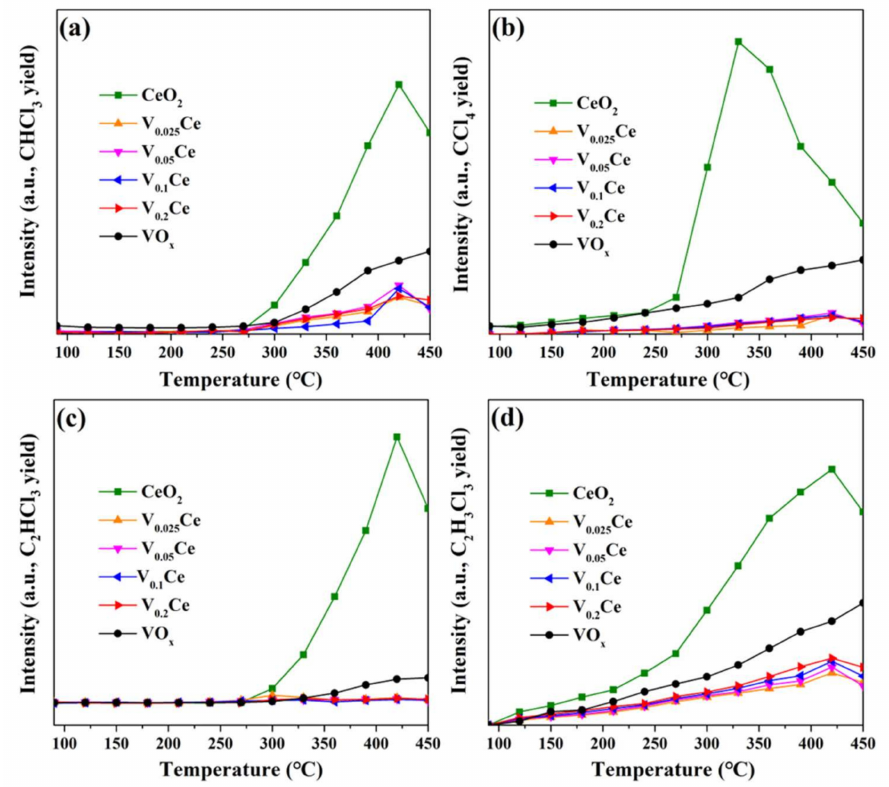
Figure 9. Chlorinated byproducts distribution in 1,2–DCE destruction over prepared